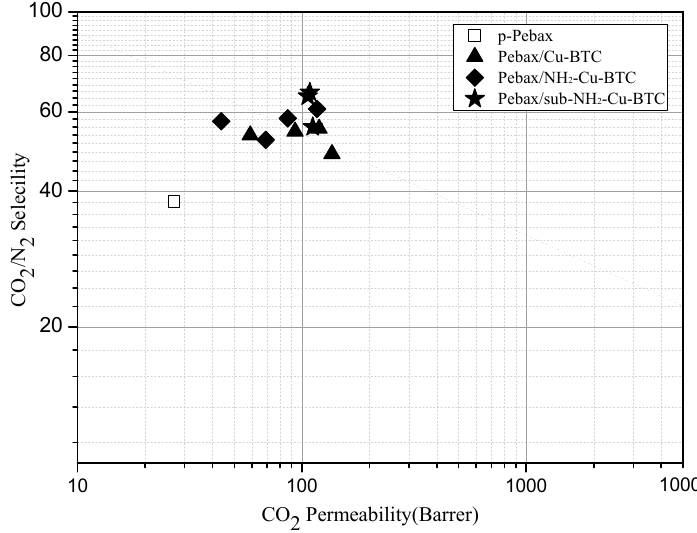
Figure 10. CO 2 /N 2 separation performance of pure Pebax ( □ ) , Pebax/Cu-BTC ( ▲ ), Pebax/NH 2 -Cu-BTC ( ◆ ) and Pebax/sub-NH 2 -Cu-BTC ( ★ ) MMMs in Robeson upper bound plot (2008).